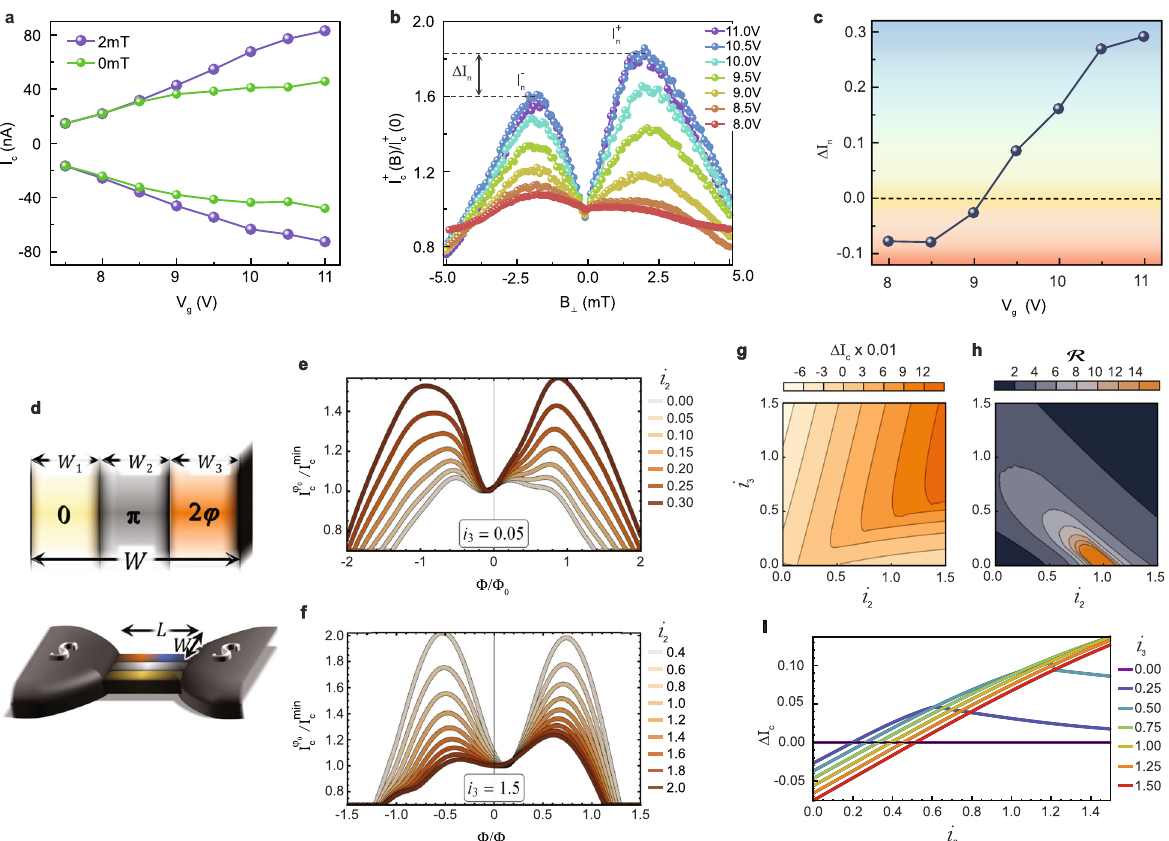
Fig. 4 Sign-reversal, three-channel model with intrinsic phases. a The evolution of the critical current estimated at constant magnetic fi elds ð B Þ = I þ ð 0 Þ vs B – V vs B 0 and + 2 mT, with gate voltages between 11 and 7.5 V. b The normalized positive critical current I þ ⊥ estimated from I c c ð 2 mT Þ (cid:2) I (cid:2) ð(cid:2) 2 mT Þ curves at different gate voltages. The dashed lines represent the value of current ( I n ) at ±2 mT. c The variation of Δ I n ¼ I þ n n as a function of V g . A clear crossing of the zero line takes place and this indicates the sign reversal at ~9.5 V. d Illustration of the three-channel theoretical model, where the total width is W = W 1 + W 2 + W 3 , with corresponding intrinsic phase drop of φ in = 0, π , and φ 0 . e , f Magnetic fl ux (cid:2) (cid:3) ð Φ Þ = I min ¼ min I φ 0 ð Φ (cid:4) 0 Þ dependence of the normalized critical current I φ 0 (where I min ) at fi xed i 3 = 0.05 and 1.5 and different values of i 2 , c c c c and equal channel widths, W 1 = W 2 = W 3 = W /3. Here, i 2 = I 20 / I 10 and i 3 = I 30 / I 10 indicate the ratios between the weights of the channels π and 0 and between the channels φ 0 and 0, respectively. g The variation of Δ I c as a function of i 2 and i 3 . Here, (cid:2) (cid:3) (cid:2) (cid:3) Δ I ¼ max I φ 0 ð Φ > 0 Þ (cid:2) max I φ 0 ð Φ < 0 Þ ð Φ Þ as a function of ( i Δ I . h The ratio R of maximum/minimum of I φ 0 c c as a 2 , i 3 ). i The variation of c c c function of i 2 at different values of i 3